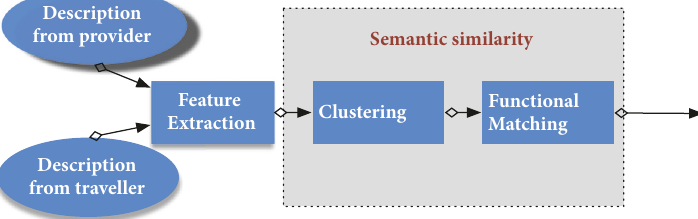
Figure 2: Matching using semantic